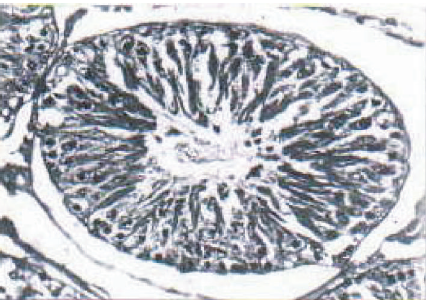
Figure 3: Microphotograph of testis of rat treated with compound 2 showing incomplete spermatogenesis. Seminiferous tubular size is reduced. Secondary spermatocyte stage showing degeneration. Lu- men is devoid of sperm. X 200